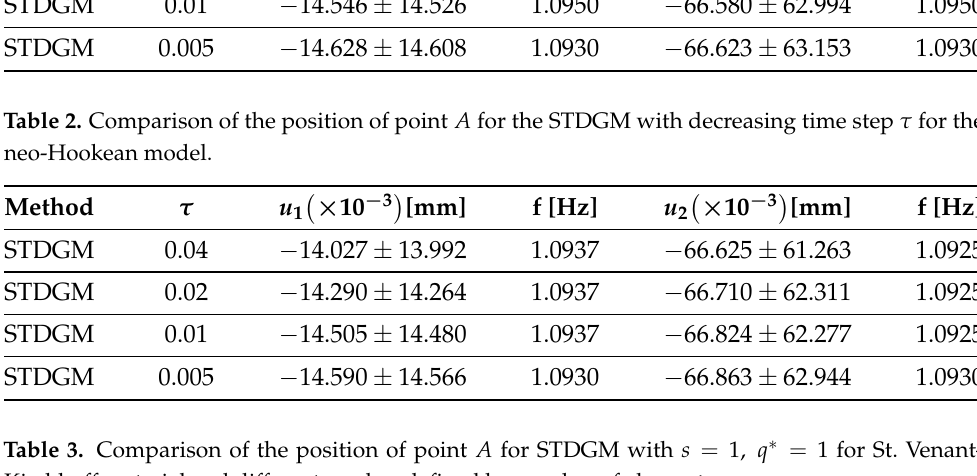
Table 3. Comparison of the position of point A for STDGM with s = 1, q ∗ = 1 for St. Venant– Kirchhoff material and different meshes defined by number of elements. Num. of